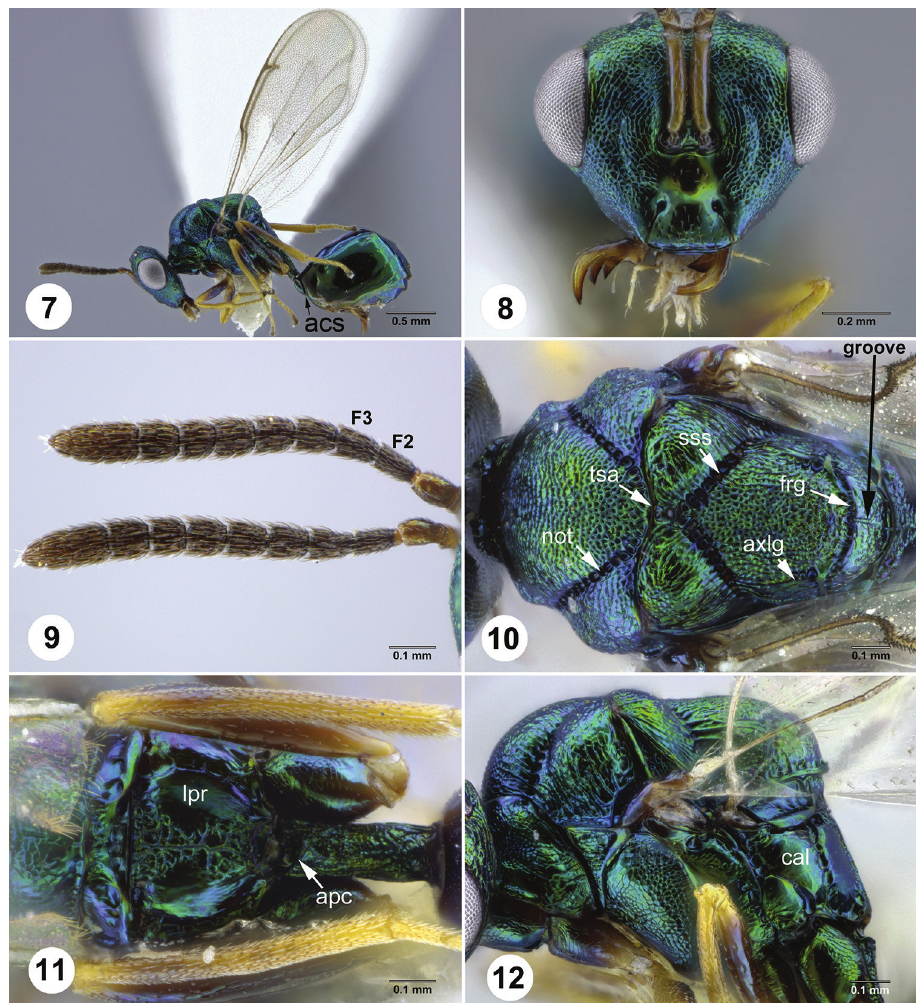
Figures 7–12. Australosema verghetta . Paratype female: 7 habitus, lateral 8 head, anterior 9 antennae, dorsal 10 mesosoma, dorsal; 11 propodeum and petiole, dorsal 12 mesosoma, lateral. acs = antecostal sul- cus; apc = anterior petiolar carina; axlg = axiullar groove; cal = callus; F = flagellomere; frg = frenal groove; lpr = lateral propodeal disc; not = notaulix; SSS = scutoscutellar sulcus; tsa = transscutal articulation. margin of prepectus, posteroventral surface with horizontal shelf that is shorter than mesepimeron but swollen and smooth anterior to mesocoxa; upper and lower mese- pimeron smooth, transepimeral sulcus foveate. Propodeal disc with a meandering median carina crossed by short transverse carinae, sublaterally smooth; callus smooth and with very short setae. Metacoxa basally rugose-reticulate, apically smooth. Fore wing 2.4–2.5× as long as broad; costal cell ventrally setose in apical half; basal